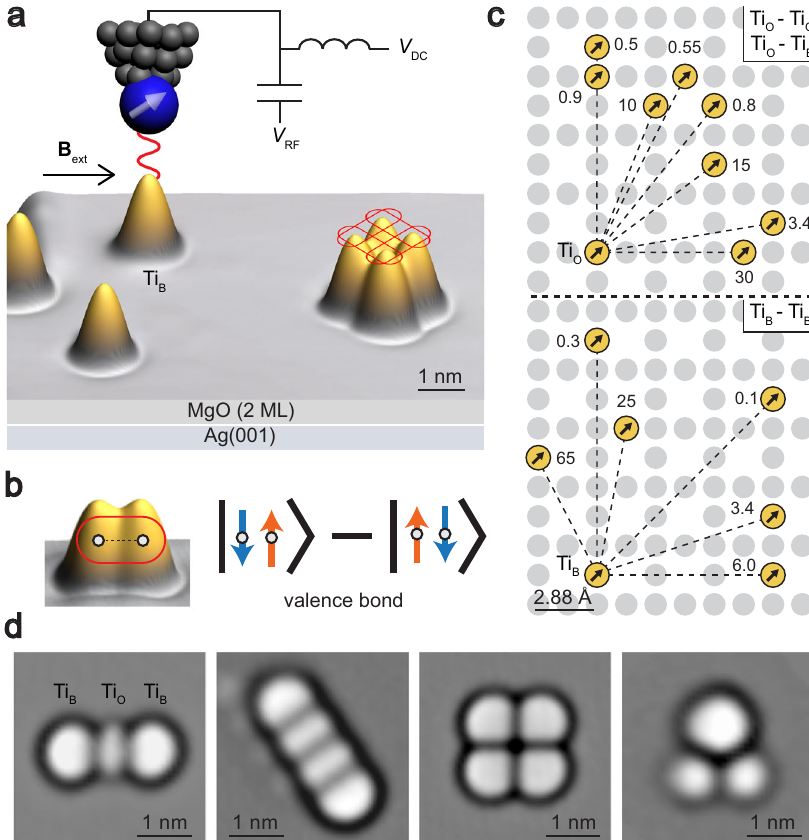
Fig. 1 Toolbox of spin-1/2 atoms on a surface. a Experimental setup showing an STM with ESR capability, and an STM image (10 × 7.8 nm) of Ti atoms on MgO/Ag(001) ( V DC = 50 mV, I DC = 30 pA). A spin-polarized tip is used to drive and sense ESR. Rounded rectangles represent valence bonds between Ti atoms positioned on the surface. b Valence bond (spin-singlet state), formed by two antiferromagnetically coupled Ti atoms. Blue and orange arrows represent spin-down and spin-up states, respectively. c Pairwise magnetic interactions (in units of GHz) for a range of different interatomic distances (Supplementary Table 1). Upper panel: Ti O – Ti O and Ti O – Ti B dimers. Lower panel: Ti B – Ti B dimers. d Laplace- fi ltered STM images (3.5 × 3.5 nm) of different quantum